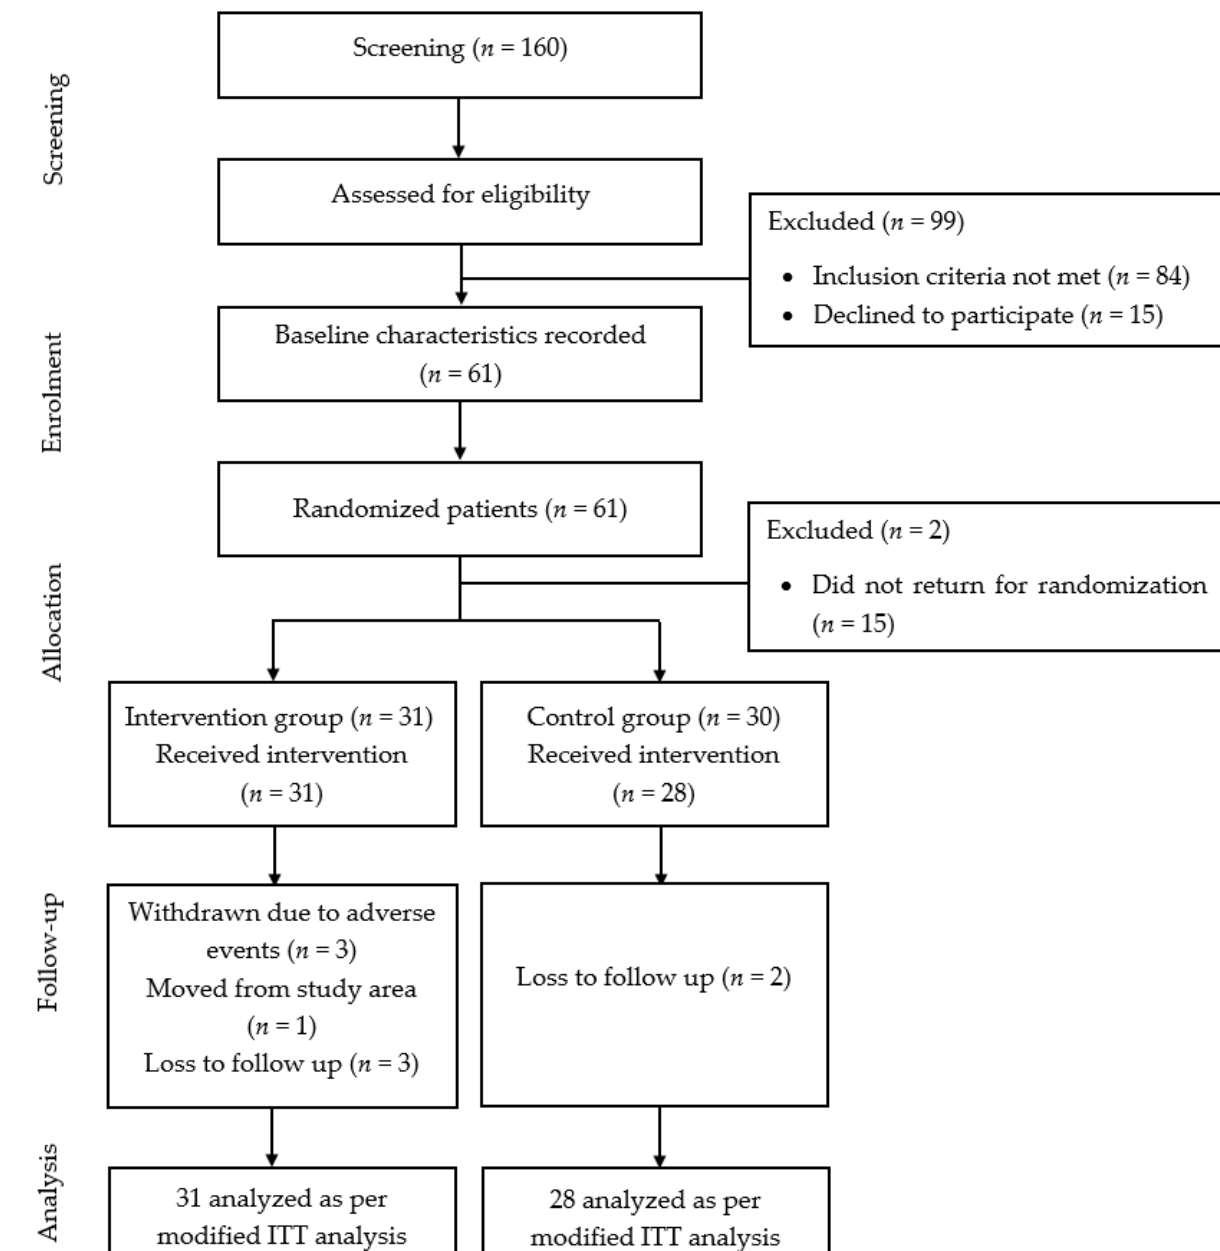
Figure 1. Summary of patient flow diagram. n : number of patients.